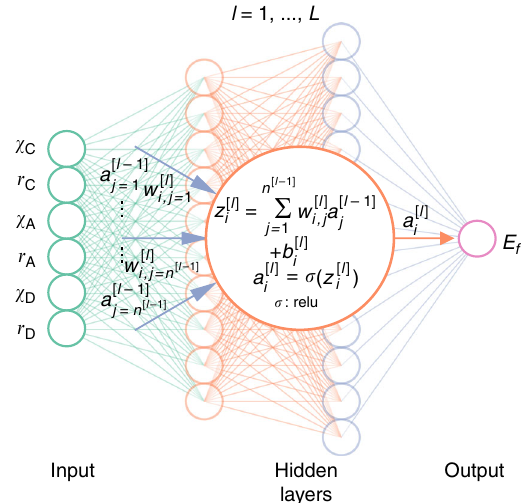
Fig. 2 General schematic of the arti fi cial neural network. The arti fi cial neural network (ANN) comprises an input layer of descriptors (the Pauling electronegativity and ionic radii on each site), followed by a number of hidden layers, and fi nally an output layer ( E f ). The large circle in the centre shows how the output of the i th neuron in l th layer, a l ½(cid:3) i , is related to the received inputs from ( l − 1) th layer a ½ l (cid:2) 1 (cid:3) j . w l ½(cid:3) i ; j and b l ½(cid:3) i denote the weight and bias between the j t h neuron in ( l − 1) th layer and i th neuron in l th layer. σ is the activation function (recti fi ed linear unit in this work). The ANN models were implemented using Keras 39 deep learning library with